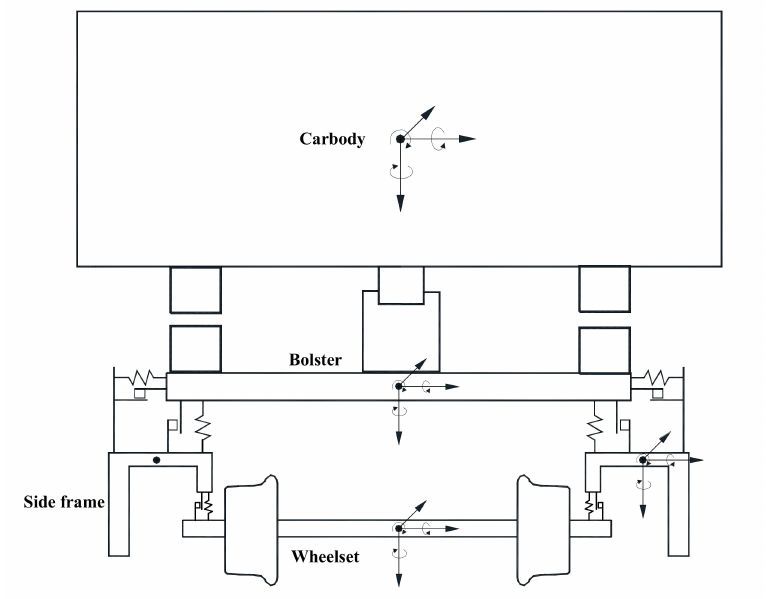
Figure 6. Schematic of the topological structure of the truck dynamics